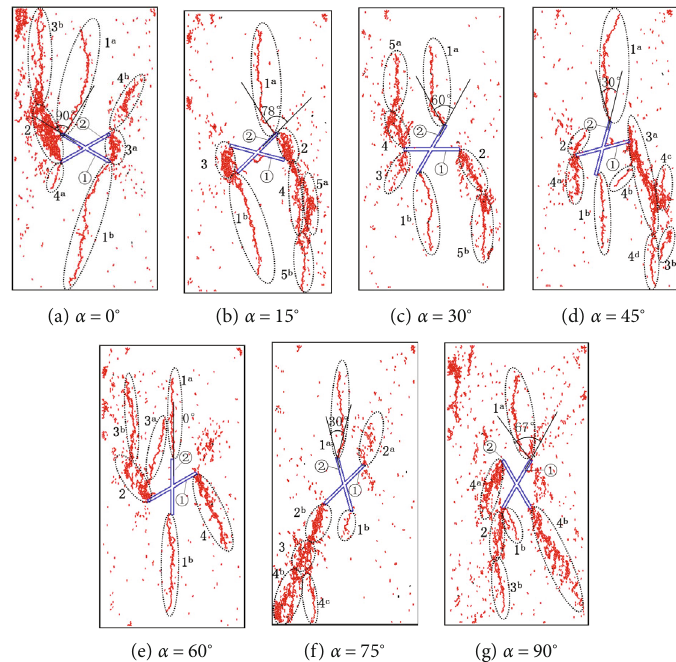
Figure 15: Failure modes of numerical models with di ff erent values of α ( β = 60 ° ). (Red represents tensile microcracks. Black represents shear microcracks. Numbers indicate the order of macrocrack generation. The angle values indicate the crack initiation angle).